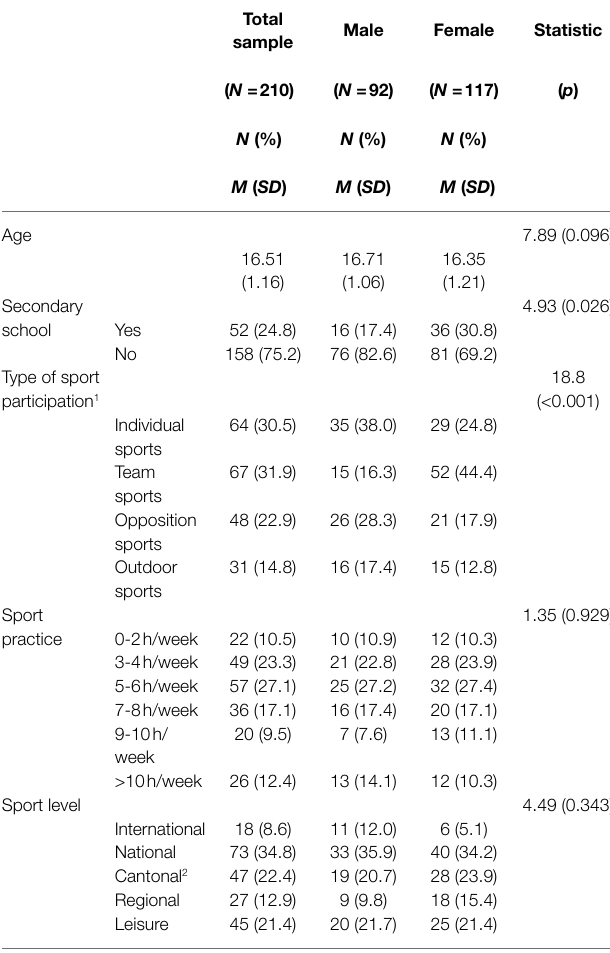
TABLE 1 | Sociodemographic and sport characteristics of the study sample and distribution by gender ( χ 2 or t -test results). Total Male sample